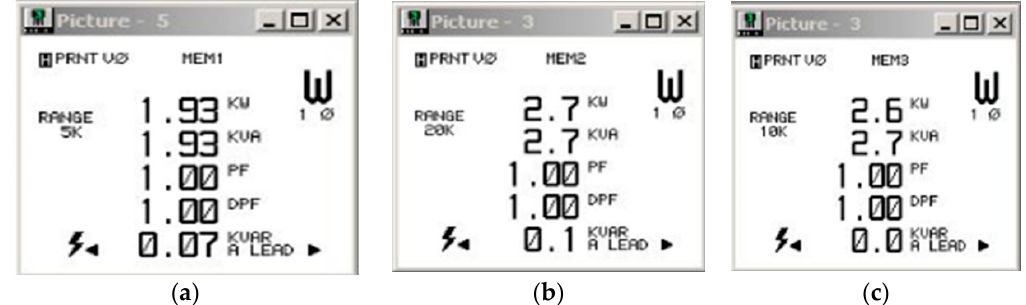
Figure 21. Powers and power factors in phases upstream of the PCC, measured at three moments of time: ( a – c ).